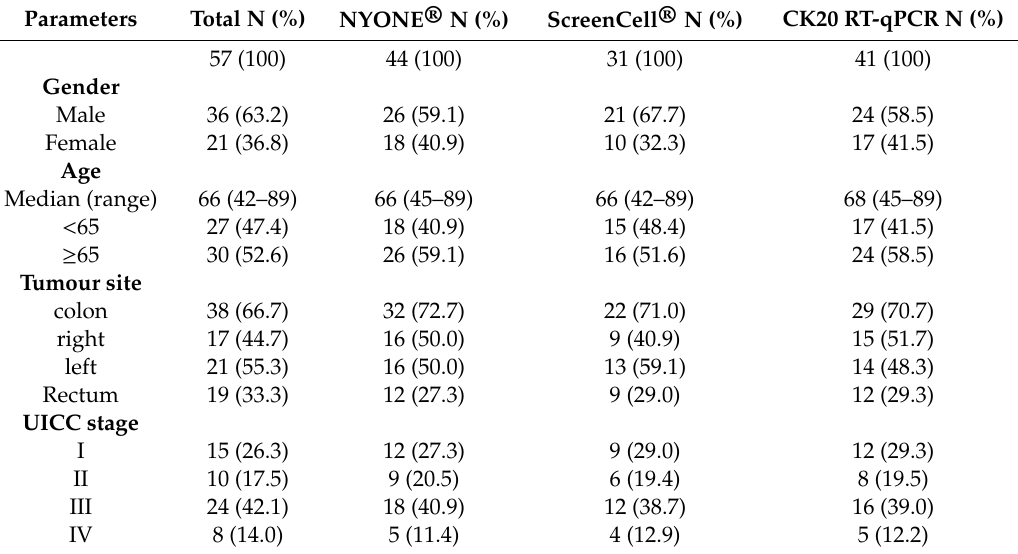
Table 1. Patient demographics and clinical characteristics of the entire study population and further breakdown according to the utilised detection